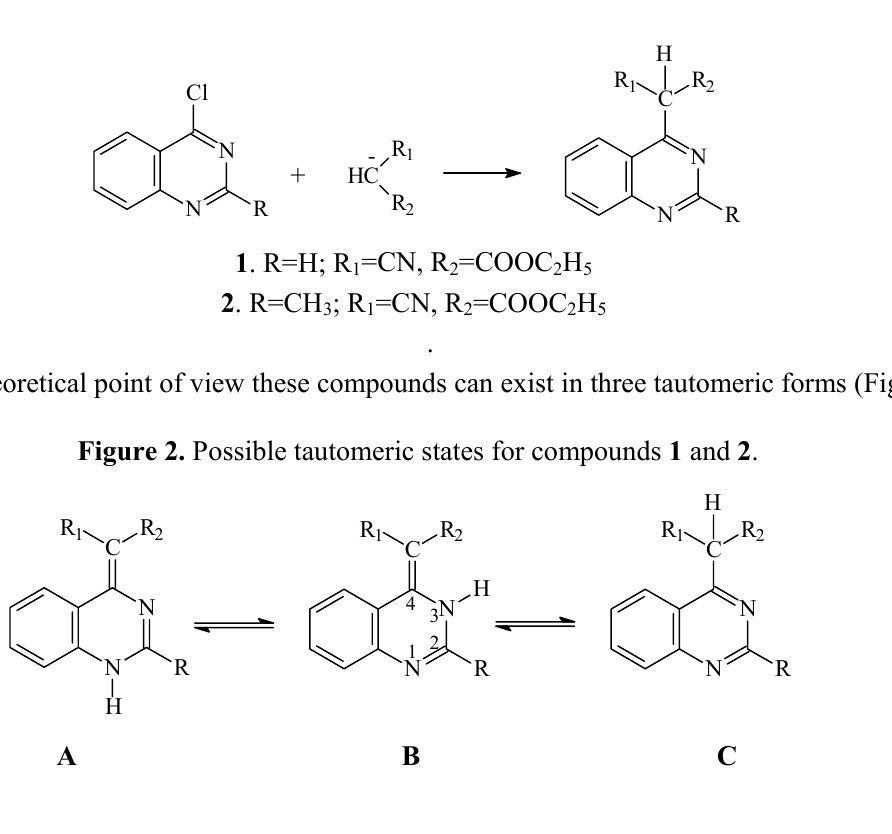
Figure 1. Structural representation and reaction scheme of compounds 1 and 2